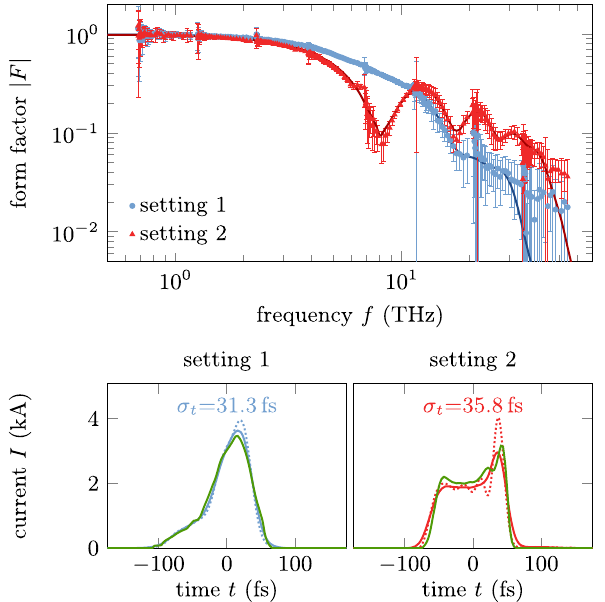
FIG. 9. Top: measured form factors as the average over 20 rf pulses for two different compression settings and the form factor of the reconstructed current profiles (lines). Bottom: recon- structed current profiles compared to the TDS profiles (green) convoluted (blue/red, solid) and not convoluted (blue/red, dashed) with the TDS time